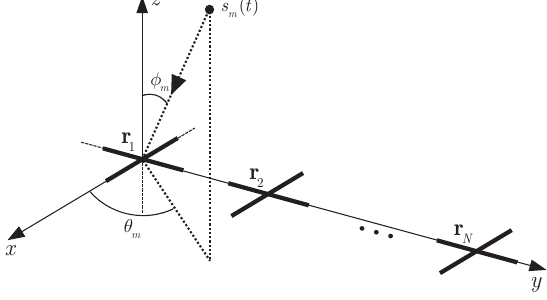
Figure 1. A crossed-dipole linear array with N vector